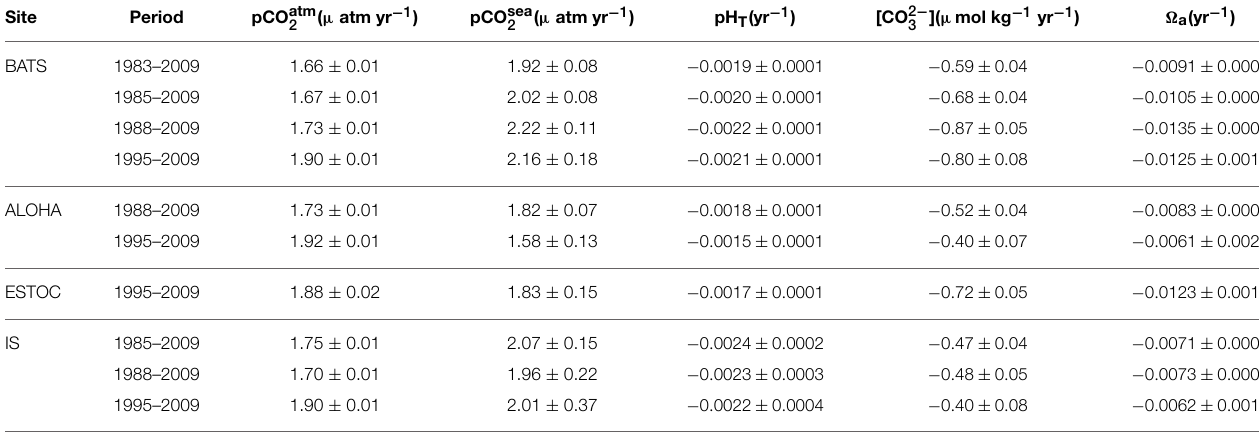
TABLE 3 | Long-term trends of atmospheric (pCO 2 atm) and seawater carbonate chemistry (i.e., surface-water pCO 2 , and corresponding calculated pH, CO 2 − 3 and aragonite saturation state ( (cid:127) a ) at four ocean time series in the North Atlantic and North Pacific oceans: (1) Bermuda Atlantic Time-series Study (BATS, 31 ◦ 40 ′ N, 64 ◦ 10 ′ W) and Hydrostation S (32 ◦ 10 ′ N, 64 ◦ 30 ′ W) from 1983 to present; (2) Hawaii Ocean Time series (HOT) at Station ALOHA (A Long-term Oligotrophic Habitat Assessment; 22 ◦ 45 ′ N, 158 ◦ 00 ′ W) from 1988 to the present); (3) European Station for Time series in the Ocean (ESTOC, 29 ◦ 10 ′ N, 15 ◦ 30 ′ W) from 1994 to the present; and (4) Iceland Sea (IS, 68.0 ◦ N, 12.67 ◦ W) from 1985 to